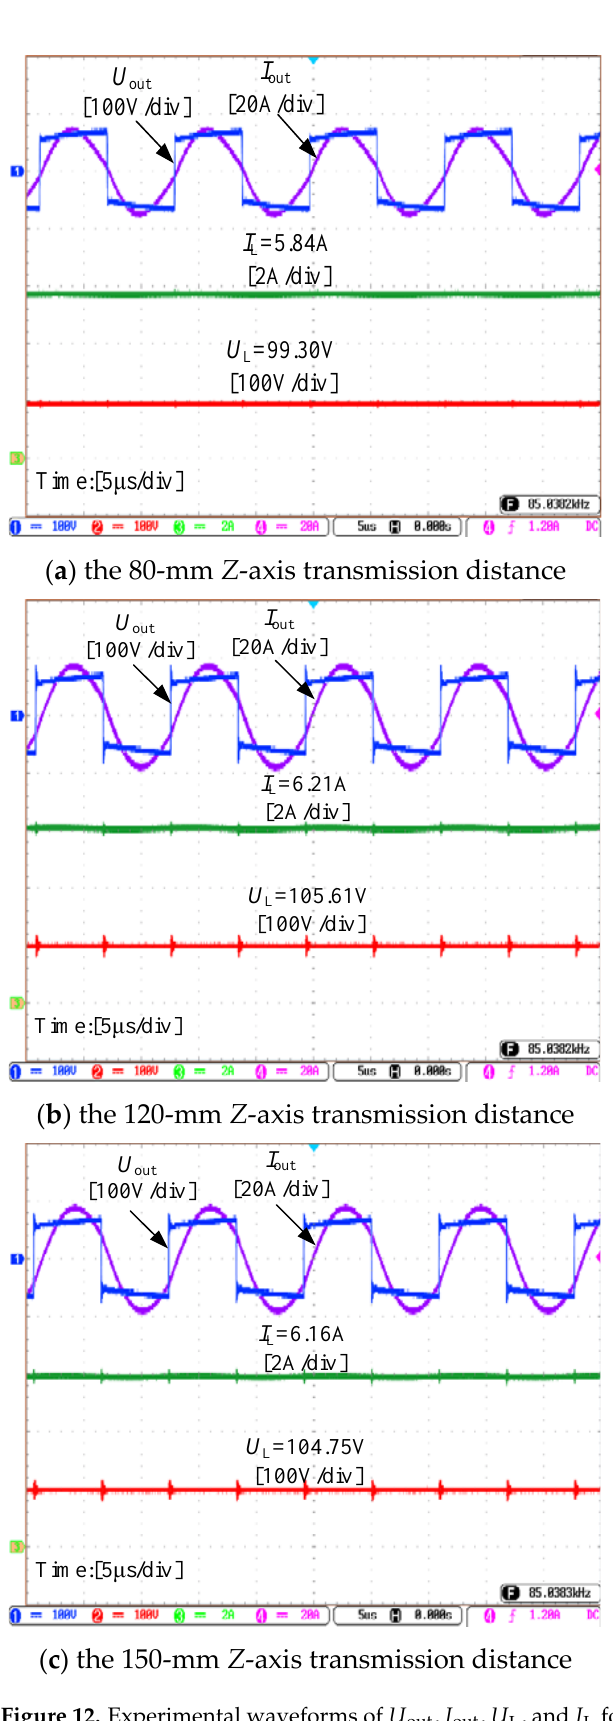
out , I out , U L , and I L for full load with R L = 17